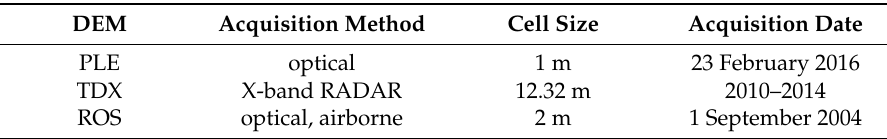
Table 2. Overview of the digital elevation models (DEMs) used in this study.